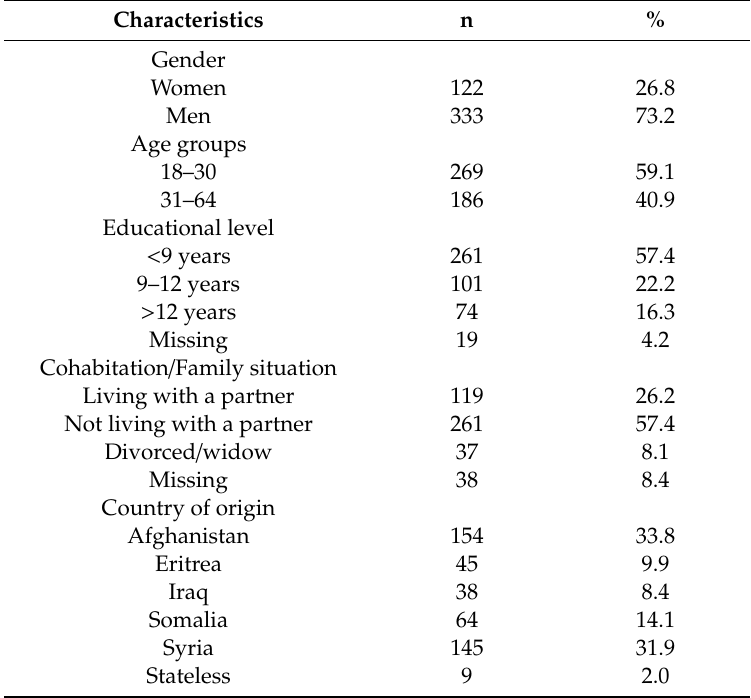
Table 1. Sociodemographic characteristics of asylum seekers in Sweden (N =